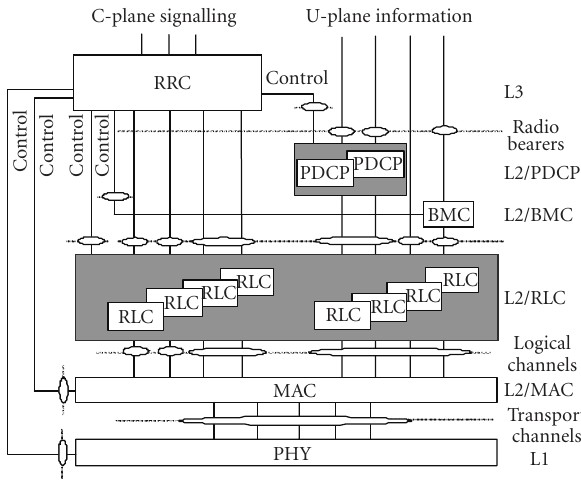
Figure 4: UTRAN protocol